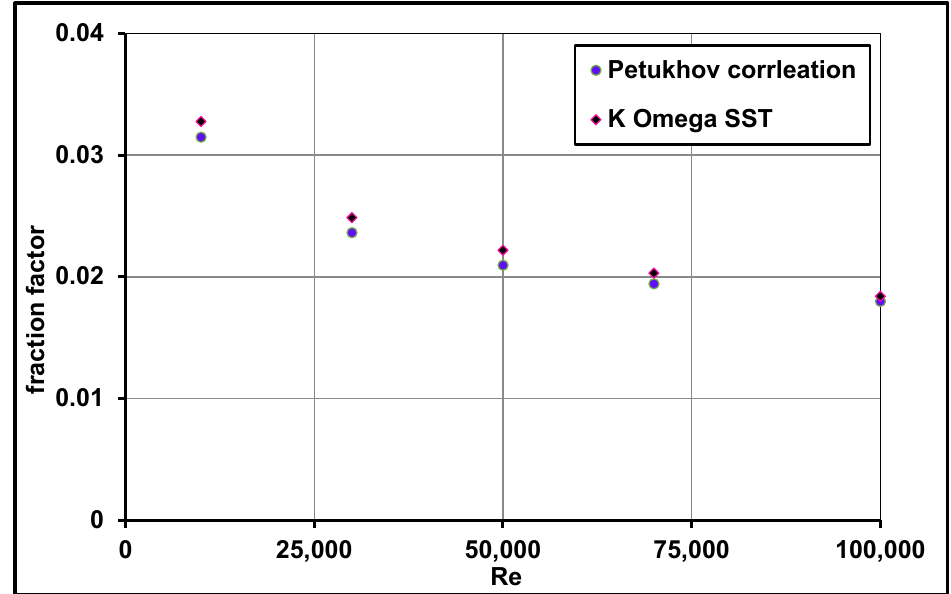
urements of Subramani et al., [75] under non-uniform heat flux distribution. All com- Figure 10. Computed friction factor comparisons with the empirical correlation of Petukhov [47]. parisons showed good agreements as shown in Figures 11 and 12. Figure 10. Computed friction factor comparisons with the empirical correlation of Petu- khov [47].